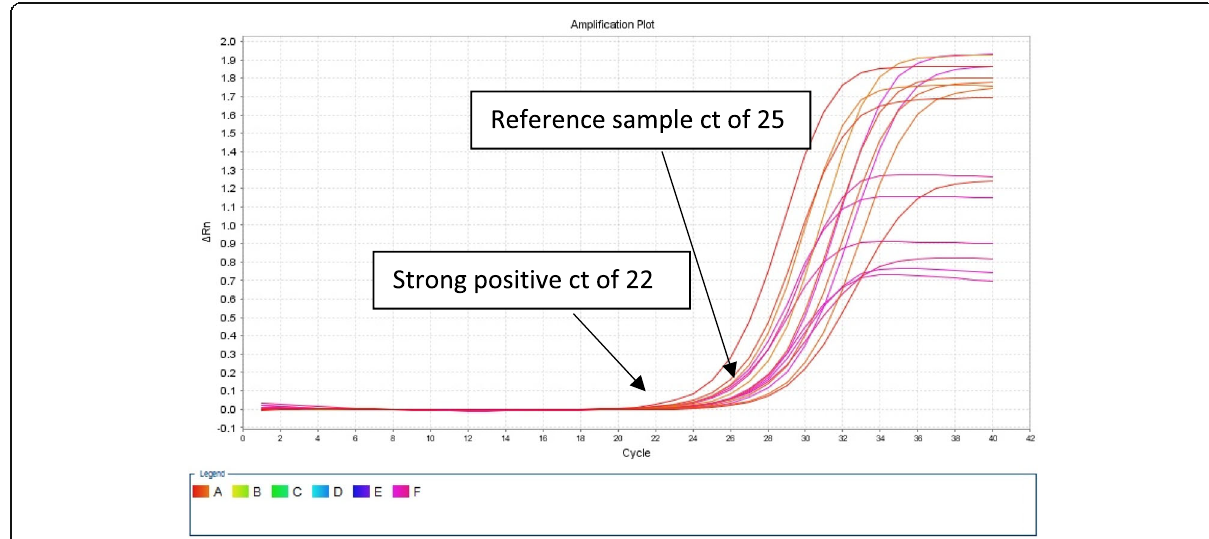
Fig. 4 Telomere amplification plot by qPCR. ct values of telomere ranging from 20 to 27 with reference ct 26 ± 3.7 and variance 14%. We also observed that most of the telomere repeat sequence ct values had wider range between ct 24 and ct